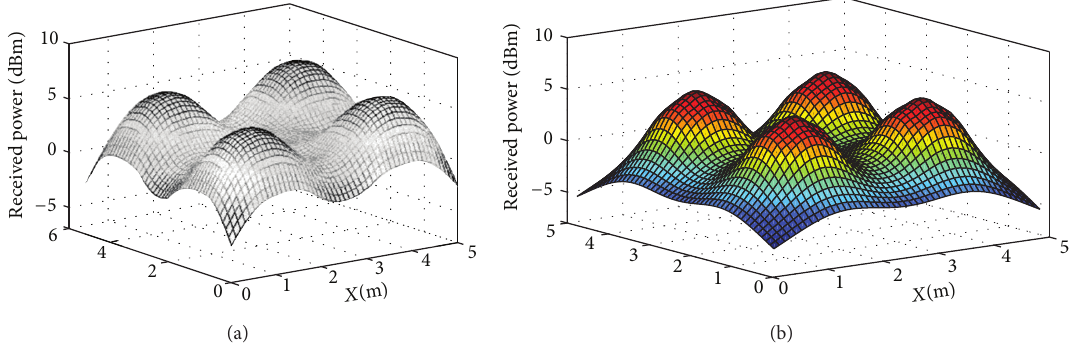
Figure 6: Received power (a) results in literature [19] and (b) simulated result.